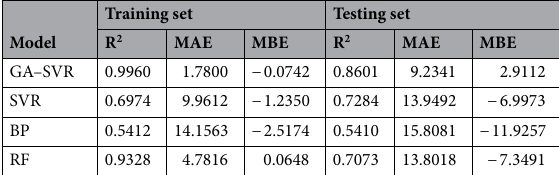
Table 1. Comparison of prediction algorithms.